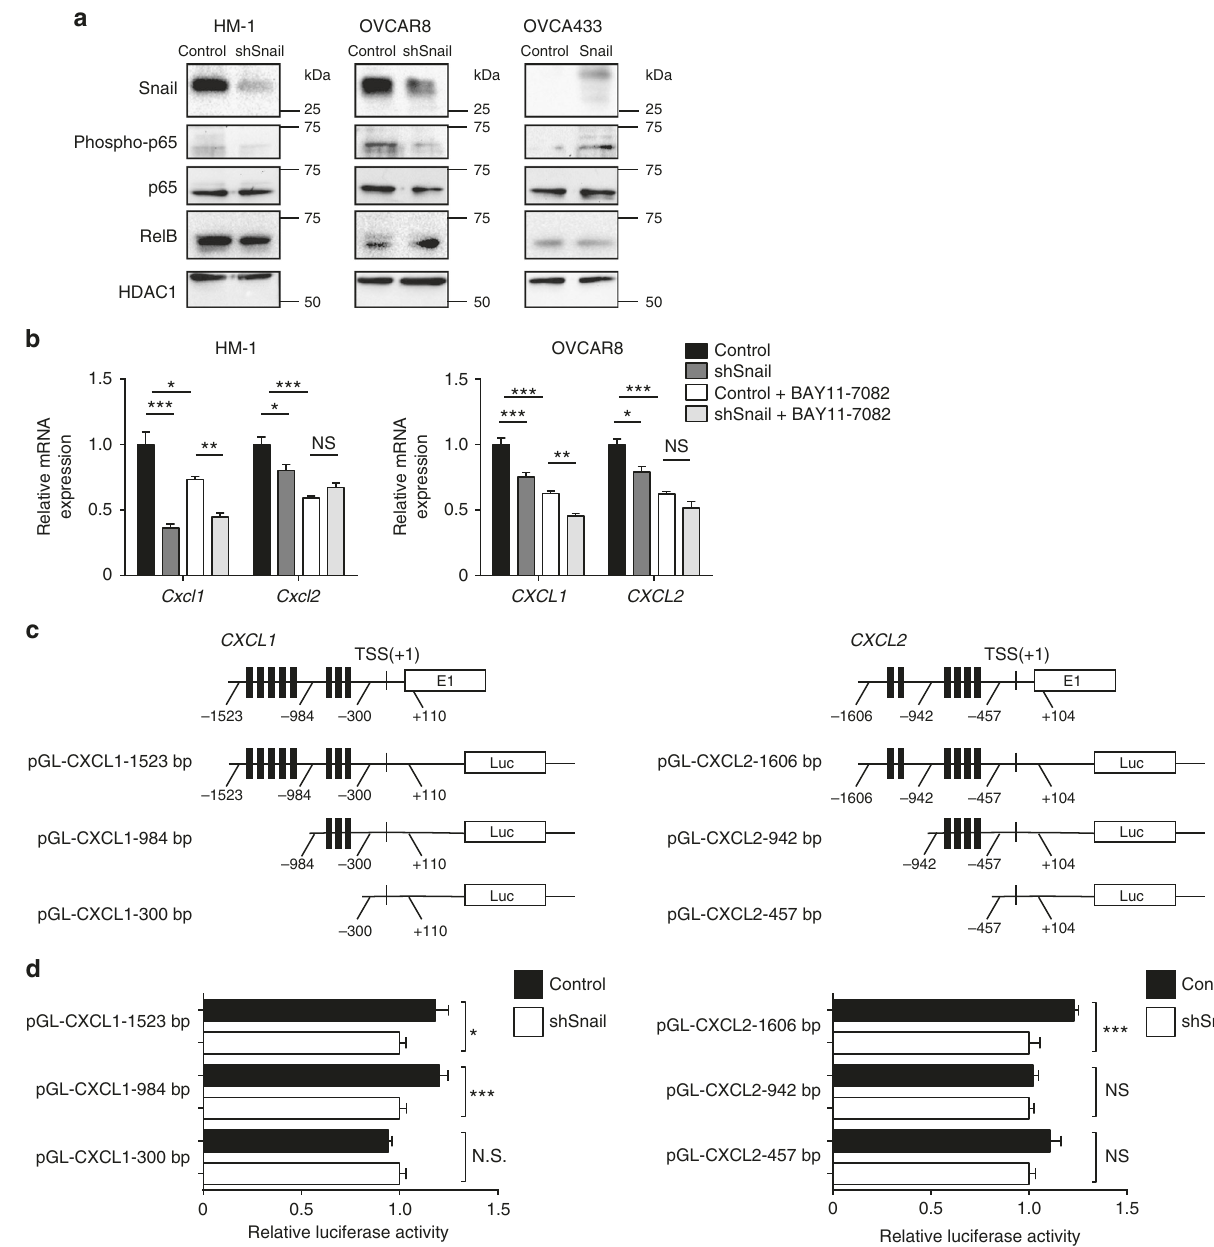
Fig. 5 Snail induces CXCL1 and CXCL2 via the NF- κ B pathway and possibly via the direct binding to their promoters. a Western blotting of nuclear Snail, phosphorylated p65 (phospho-p65), p65 and RelB from HM-1, OVCAR8 and OVCA433 cells. HDAC1 was used as control. b Reverse transcription polymerase chain reaction (RT-PCR) to analyze the expression of Cxcl1 and Cxcl2 in HM-1-control and HM-1-shSnail cells (left), and the expression of CXCL1 and CXCL2 in OVCAR8-control and OVCAR8-shSnail cells (right), treated with or without BAY11-7082 (NF- κ B inhibitor) at 10 μ M for 24 h; n = 4. c Schematic representation of CXCL1 and CXCL2 promoter organization, and the corresponding luciferase reporter constructs pGL-CXCL1 (1523 bp: − 1523 to + 110 bp, 984 bp: − 984 to + 110 bp, 300 bp: − 300 to + 110 bp) and pGL-CXCL2 (1606bp: − 1606 to + 104 bp, 942 bp: − 942 to + 104 bp, 457 bp: − 457 to + 104 bp). TSS transcriptional start site, E1 exon1, and Luc luciferase. The black bars indicate E-boxes (CANNTG), which are the binding sites of Snail. d Luciferase reporter assays to analyze the activity of the pGL-CXCL1 and pGL-CXCL2 promoter constructs in 293FT-control and 293FT-shSnail cells. Relative luciferase activities are shown; n = 5. * P < 0.05, ** P < 0.01, and *** P < 0.001 (one-way ANOVA with Tukey ’ s multiple comparisons test in b ; unpaired t -test in d ). Averaged data are presented as the mean ±